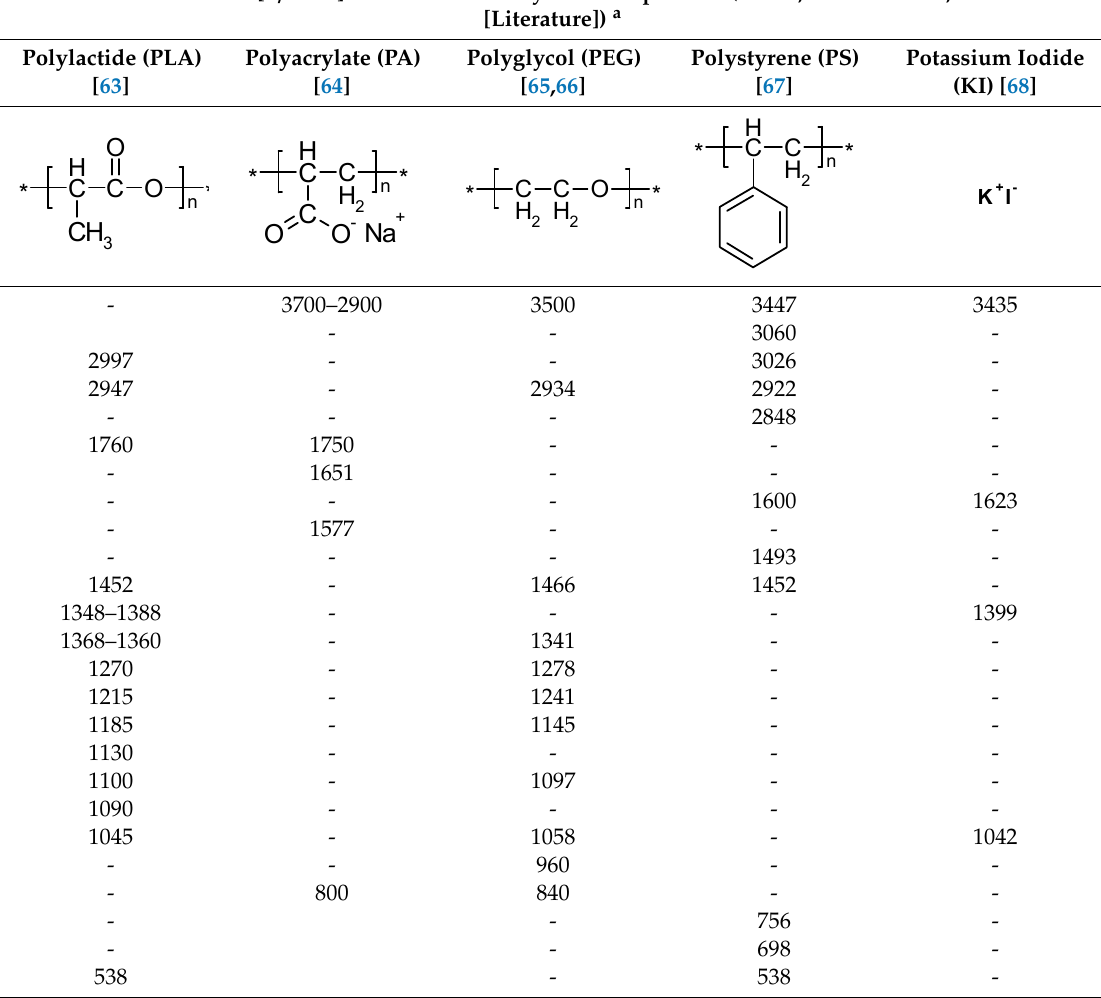
Table 4. Characteristic FTIR bands of components of PLA-SM-KI composite quoted in the literature.